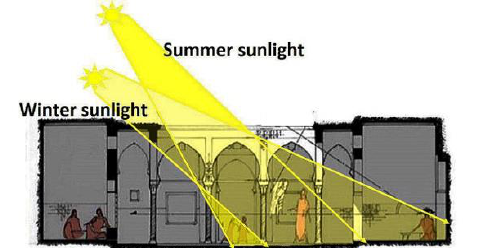
Figure 5. Solar radiation in a patio of an Algiers Casbah house (Benchekroun, 2019 treated by the authors)